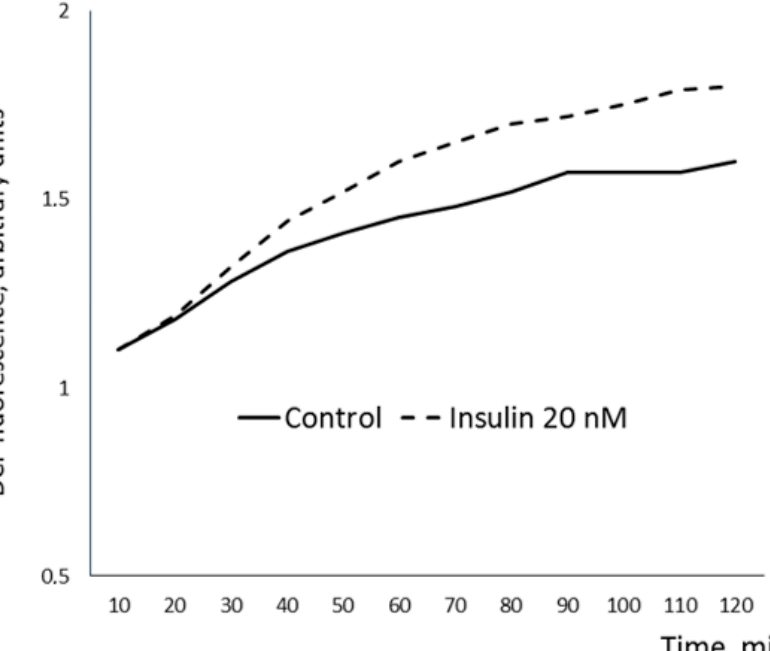
Figure 4. Representative dynamics of insulin-dependent ROS generation in EAT adipocytes. X axis—time, min; Y axis—2,3-dihydrodichlorofluorescein (DCF) fluorescence, arbitrary units, reference to blank. EAT, epicardial adipose tissue; ROS, reactive oxygen spices.